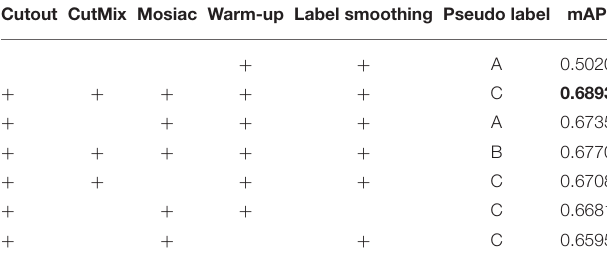
TABLE 4 | Ablation experiment results on our model512.